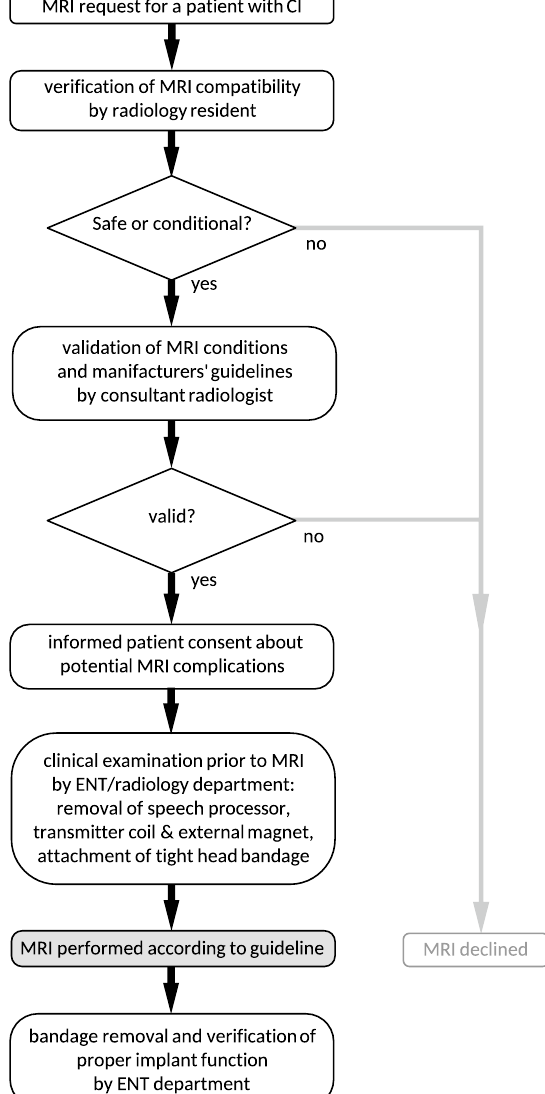
Fig. 5 SOP diagram for MRI examinations with cochlear